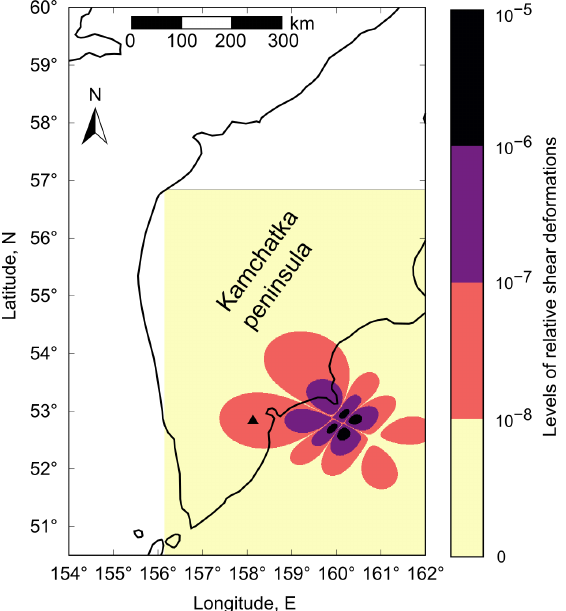
Figure 7. Zones of relative shear deformations on the Earth’s surface z = 0 simulated for earth- quake No. 2. The triangle on the map indicates the location of the Karymshina observation